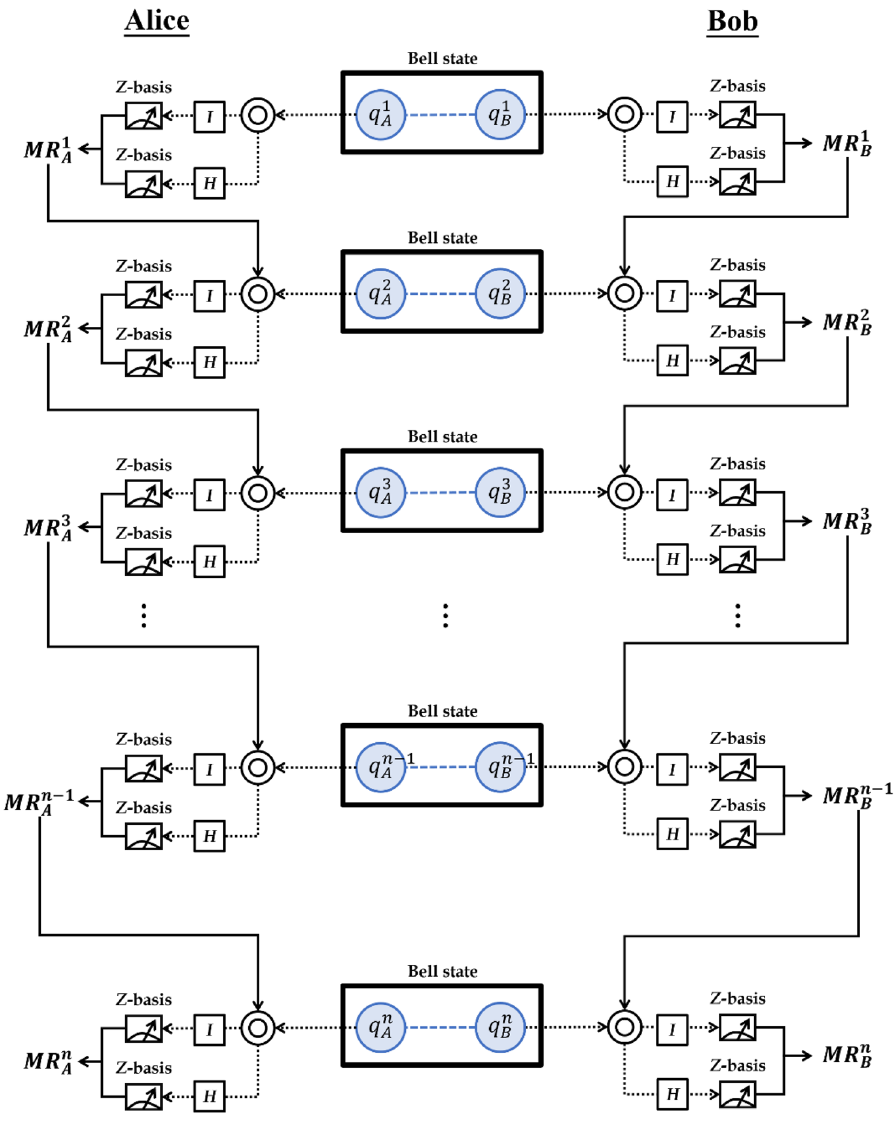
Figure 1. Concept of the coding